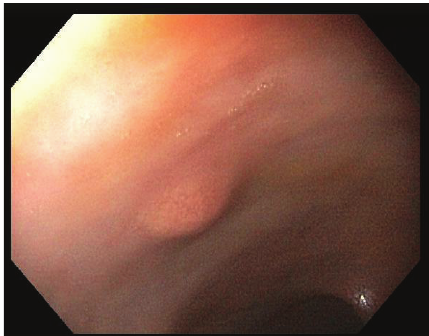
Figure 3: Neuroendocrine tumor after endoscopic mucosal resec-